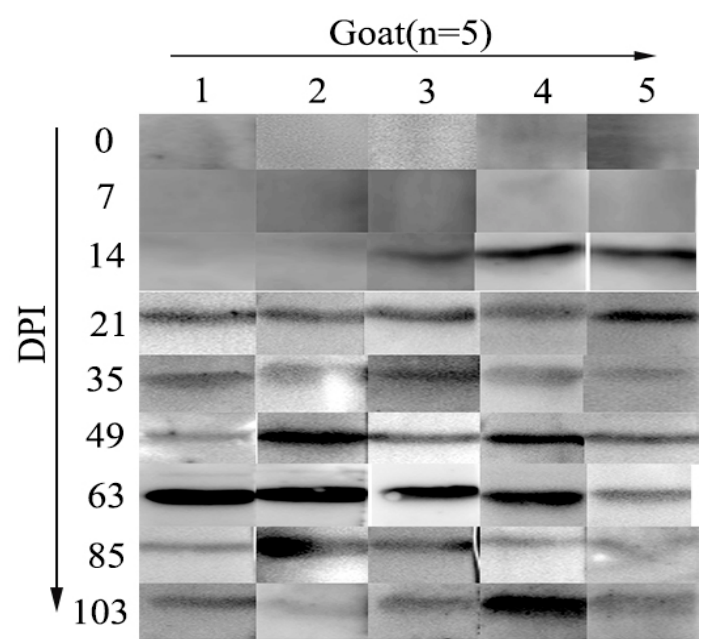
Figure 2. Western blotting showed the reactions between rHcRas and sera from goats ( n = 5) infected with H. contortus . X axis: 1, 2, 3, 4, and 5 represent five goats. Y axis: serum collected at 0, 7, 14, 21, 35, 49, 63, 85, and 103 days post